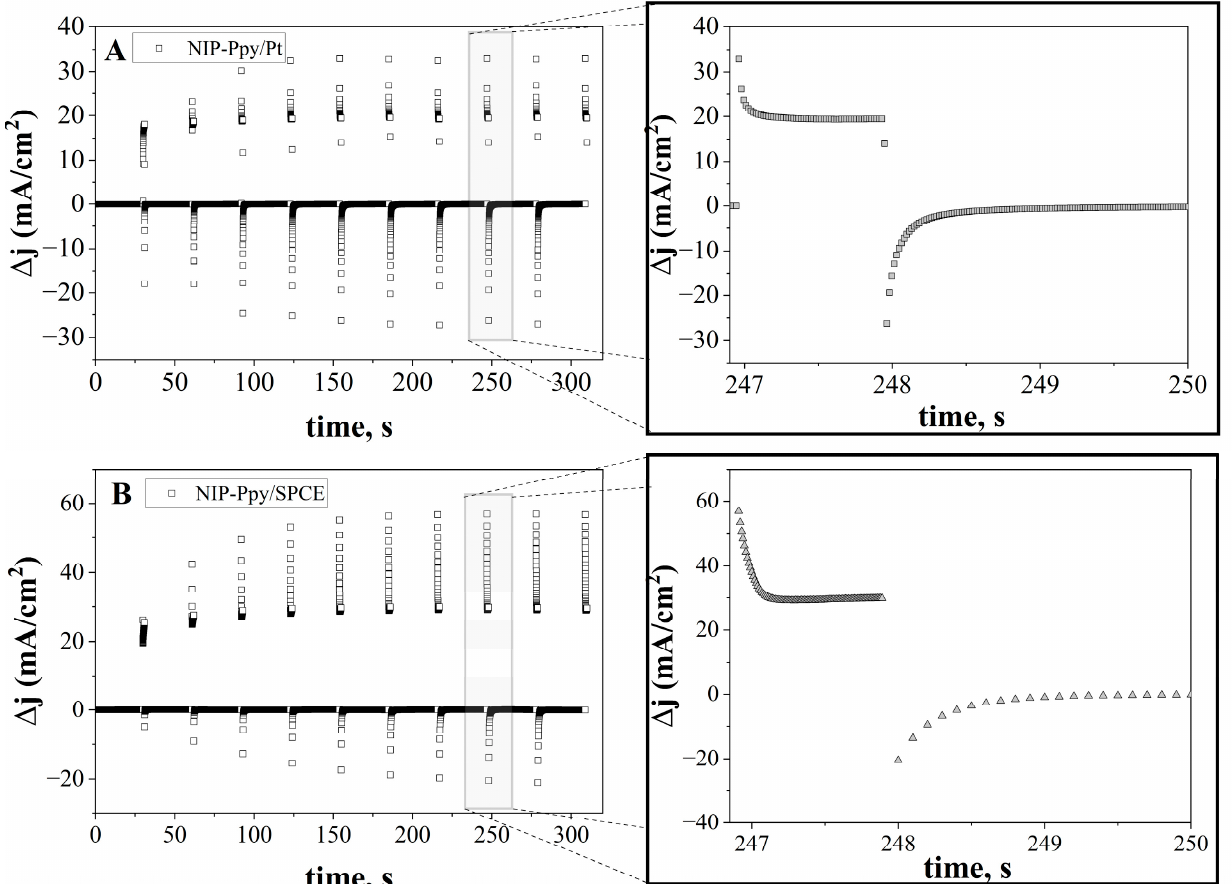
Figure 2. Current pro fi les registered during the deposition of Ppy underlayers ( A ) on Pt electrodes (second electrochemical system), and ( B ) on SPCE electrodes ( fi rst electrochemical system). Current pro fi les registered during electrochemical deposition of the polypyrrole layers with entrapped Listeria monocytogenes bacteria ( C ) on Pt electrodes (2nd electrochemical system), and ( D ) on SPCE electrodes (1st electrochemical system).